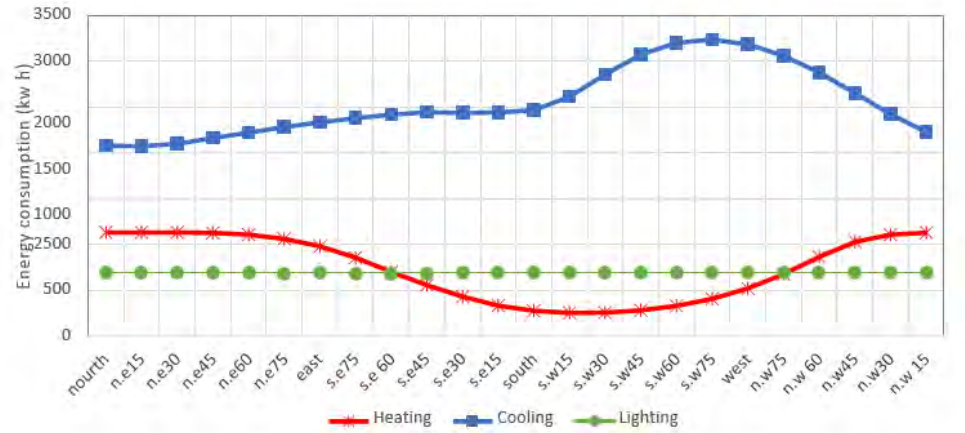
Figure 4. Total energy consumed annually in the cooling, heating and lighting in different